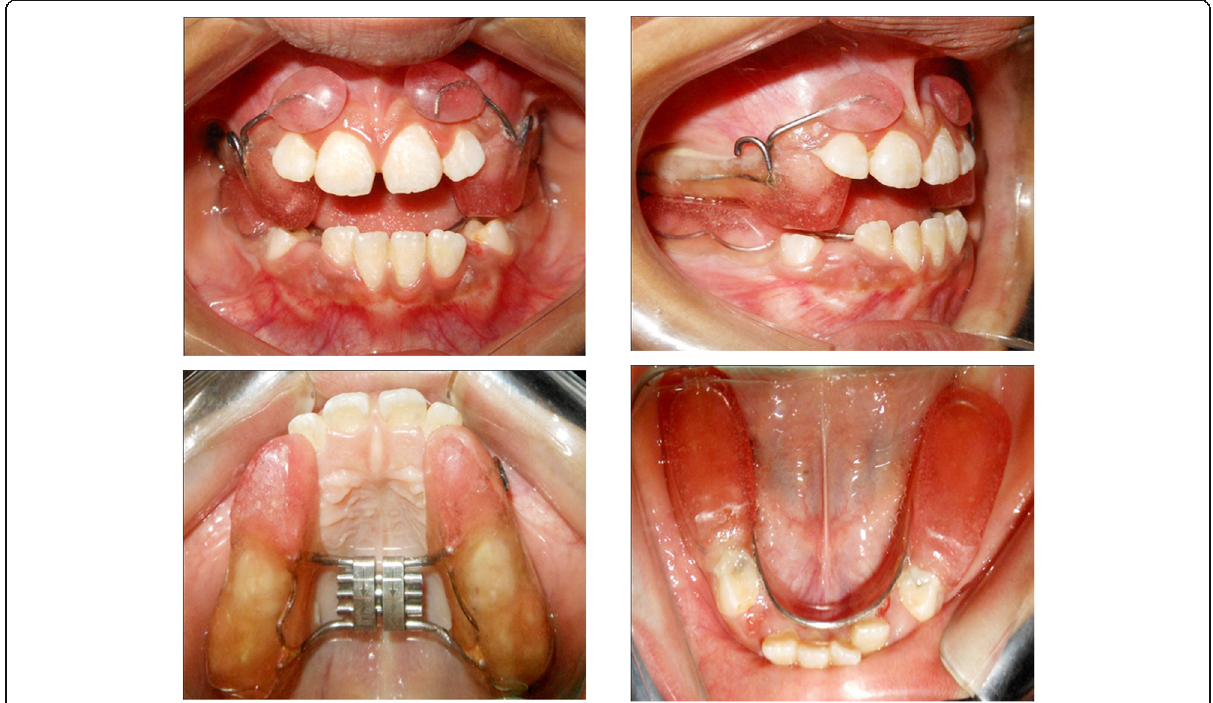
Fig. 2 Reverse twin block with lip pads-RME (RTBLP-RME)